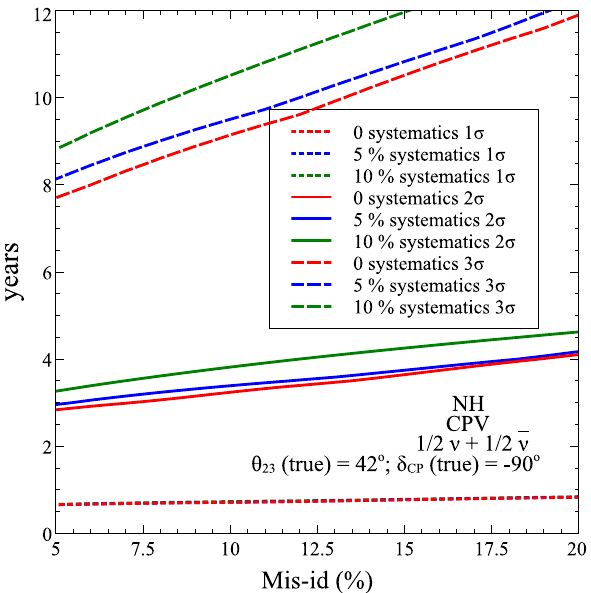
Fig. 8 Effect of background and systematics for CPV discovery in NH. in terms of runtime required to achieve a sensitivity of a certain confidence level. This is shown for θ 23 (true) = 42 ◦ and δ CP (true) = − 90 ◦ as for this set of parameters are close to the present best-fit